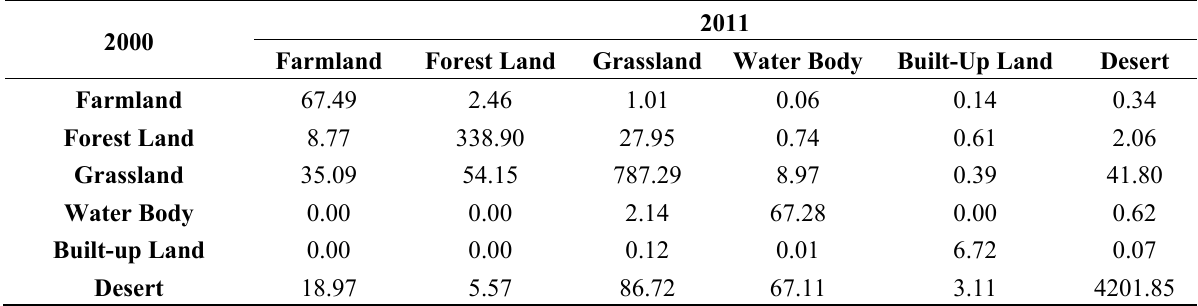
Table 2. Dynamic transition matrixes of land use types between 2000 and 2011 (km 2 ).